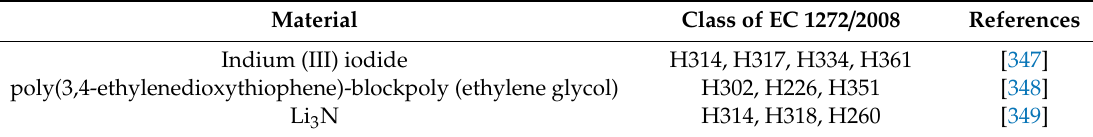
Table 13. Hazard statements of indium (III) iodide, poly(3,4-ethylenedioxythiophene)-blockpoly (ethylene glycol), and Li 3